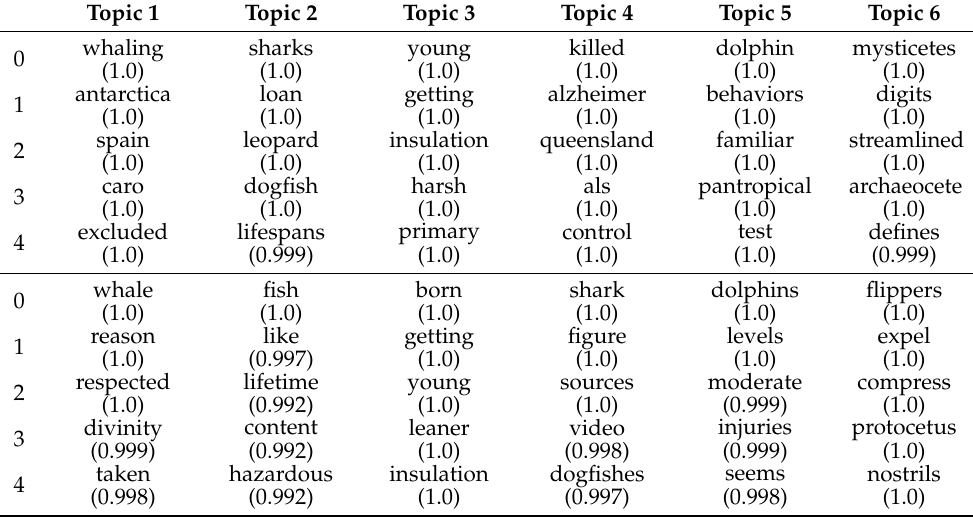
Table A13. For the most significant two words per topic, the four nearest neighbors based on cosine similarity are